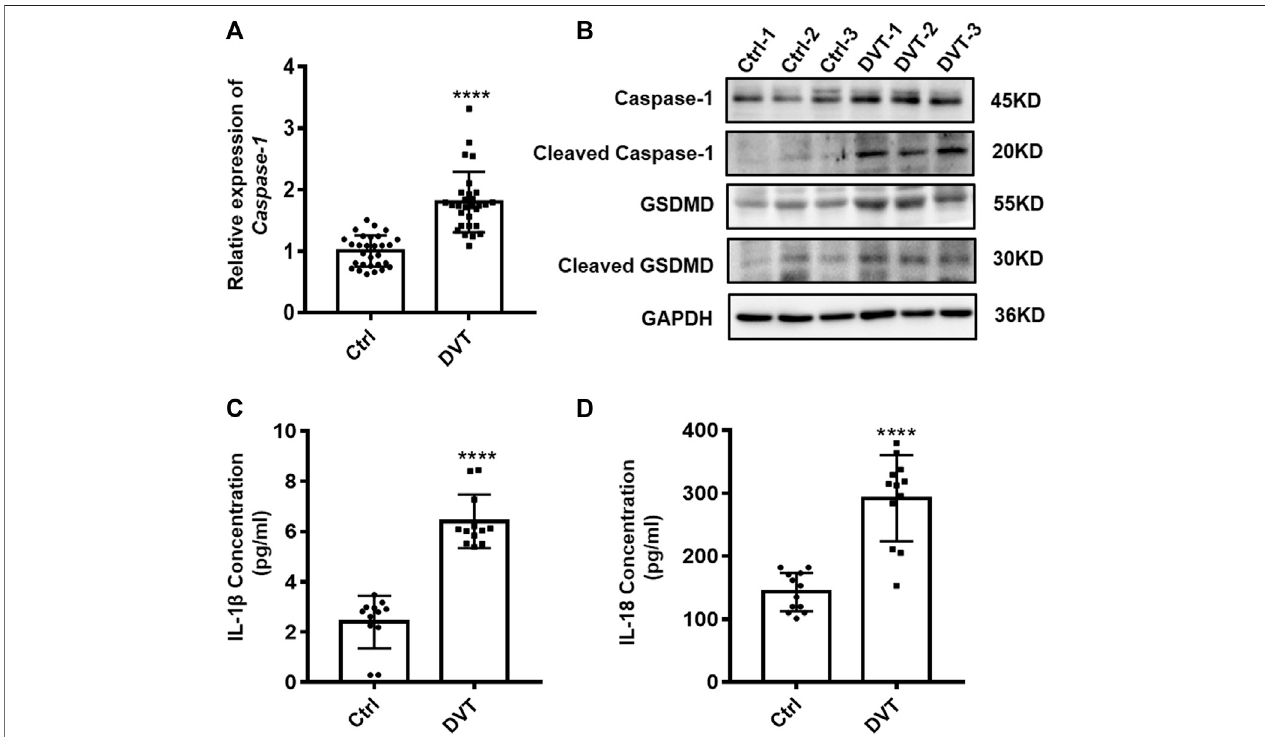
FIGURE 1 | Expressions of caspase-1, GSDMD, IL-1 β , and IL-18 are up-regulated in DVT patients. (A) mRNA level of caspase-1 in the PBMCs from 30 DVT patients and 30 controls was determined by qRT-PCR. (B) Caspase-1 and GSDMD protein levels were measured in PBMCs of DVT subjects and controls by Western blot. (C,D) Protein levels of IL-1 β and IL-18 in the serum from 12 DVT patients and 12 controls were determined by ELISA. **** p < 0.0001.